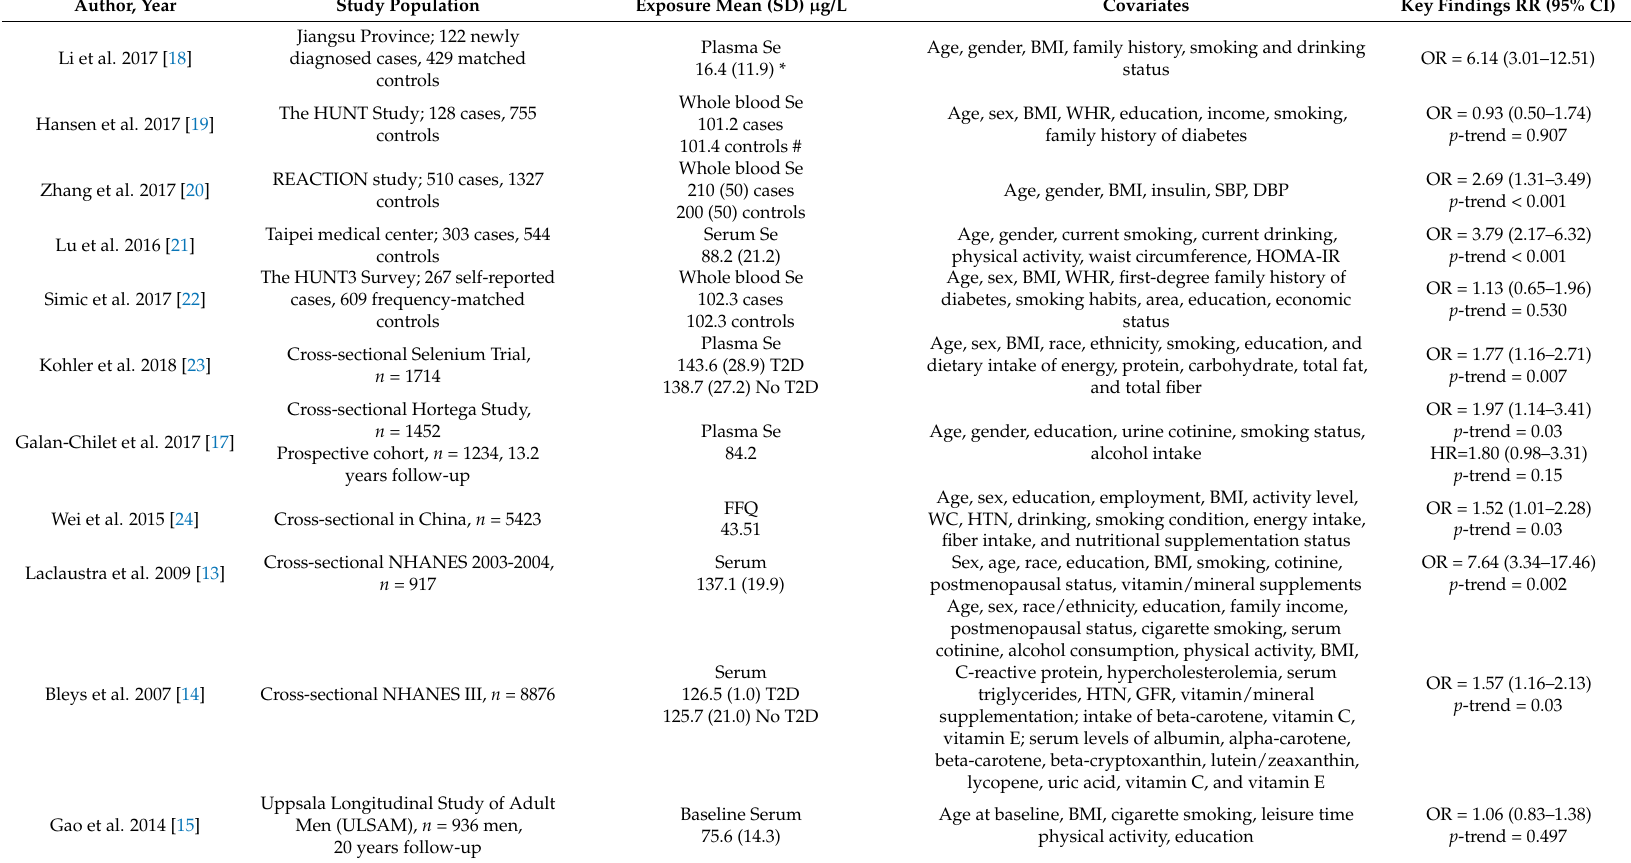
Table 1. The 15 manuscripts that met the a priori criteria for